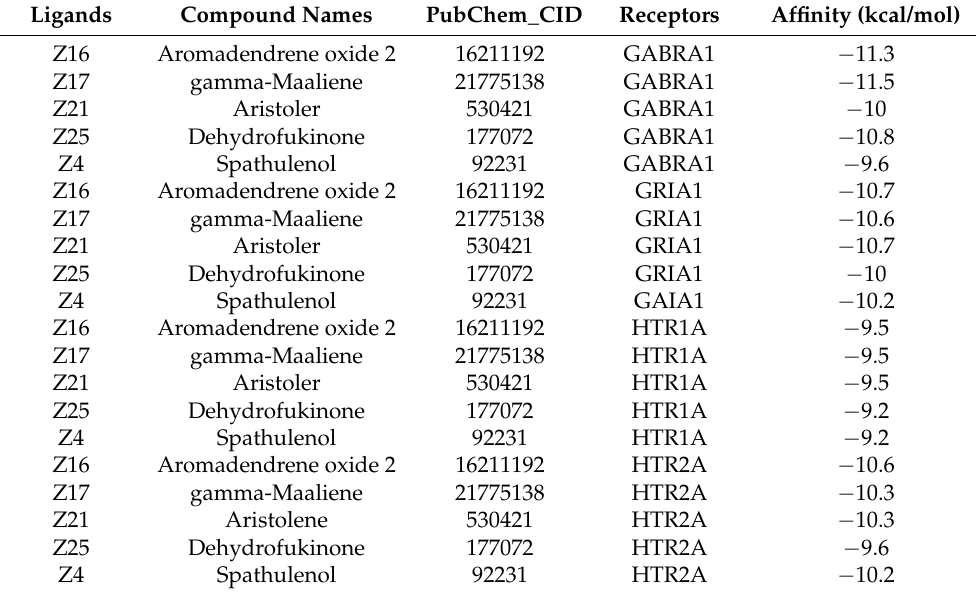
Table 2. Docking results of five core components with four